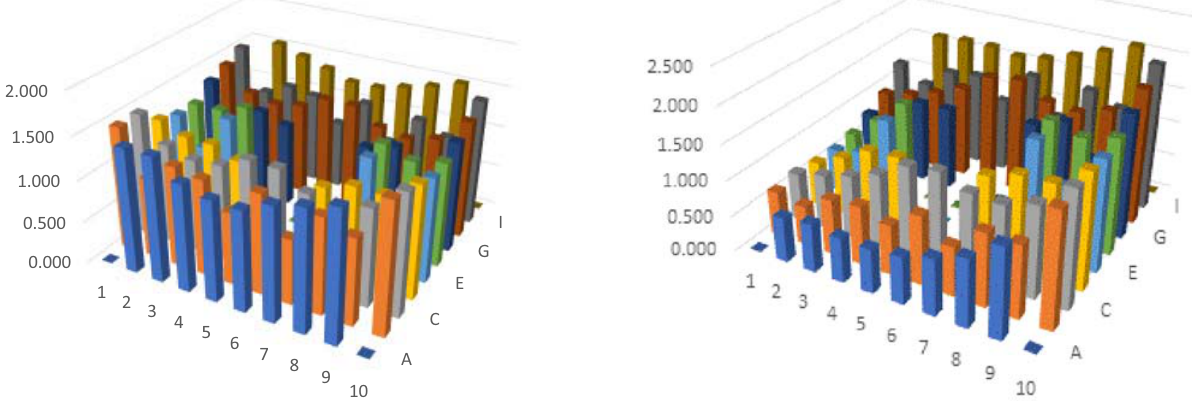
Figure 5. Normalized pin power distribution in the middle axial section of SVEA-96 Optima2 (left: unrodded, right: rodded) obtained with TORT-TD/CTF.